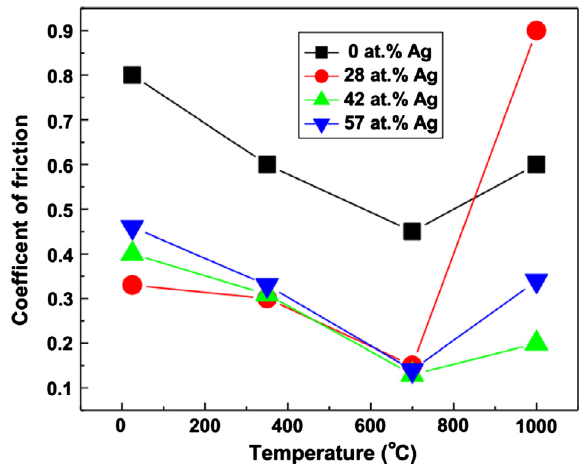
Figure 4. The effect of silver amount in the VN coating on the coefficient of friction for a sliding test performed against Si 3 N 4 ball using a 2N load [26].